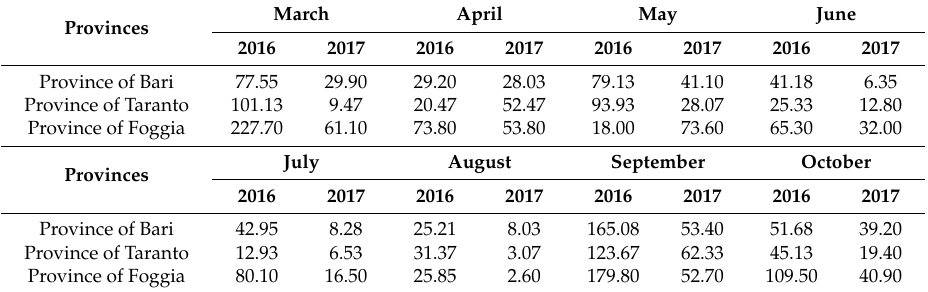
Table 2. Rainfall levels (average monthly rainfall, expressed in mm) detected by the monitoring network of the Apulia region stations in the provinces of Bari, Taranto and